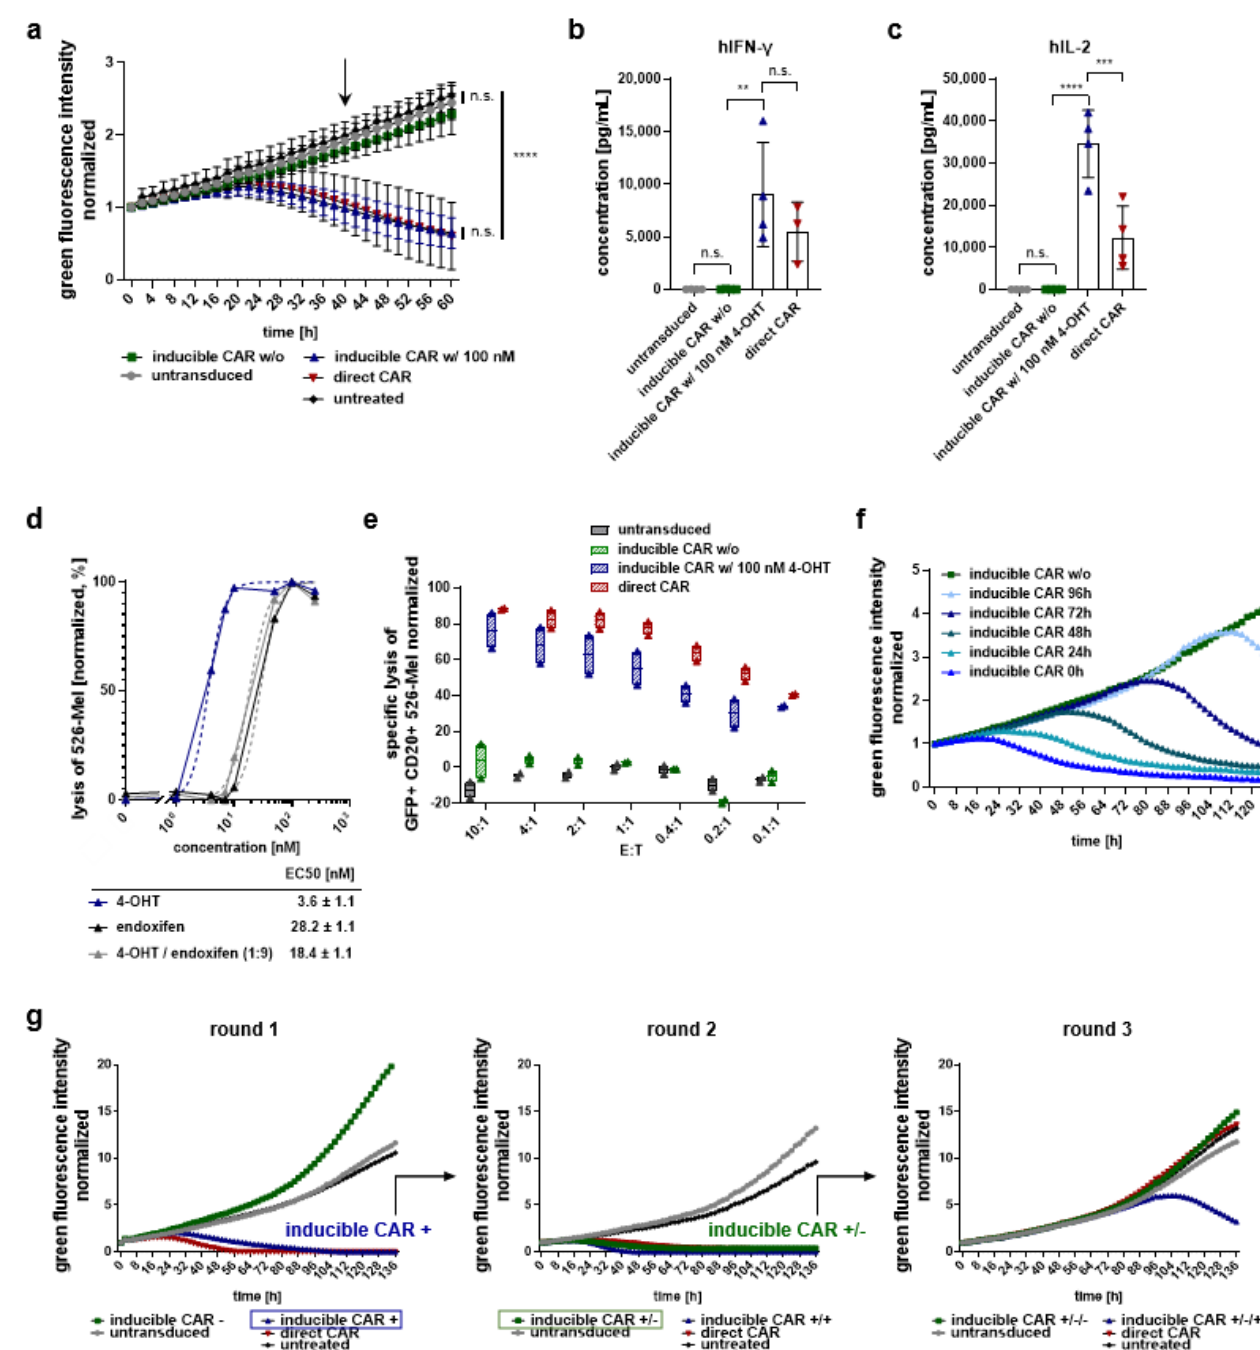
Figure 2. Inducible CAR T cells show efficient cytotoxic activity in the presence of 4-OHT, while CAR-related functions are lost after 4-OHT discontinuation in vitro. ( a ) T cells expressing ∆ LNGFR were co-cultured with GFP + CD20+ 526-Mel at an E–T ratio of 1:1 in the presence of 100 nM 4-OHT added at the start of the assay. T cell numbers were adjusted to LNGFR expression implicating equal transduced and total T cell numbers in each well. Growth of GFP + CD20 + 526-Mel was monitored in 2 h intervals over a period of 60 h using a live-cell imaging device (IncuCyte). The arrow indicates the time point of cytokine analysis. ( b , c ) The concentration of human IFN- γ ( b ) and IL-2 ( c ) was analyzed in the supernatant 40 h after assay initiation by MACSPlex Cytokine 12 Kit. ( d ) Inducible CAR T cells were co-cultured with GFP + CD20 + 526-Mel at an E–T ratio of 1:1 in the presence of varying concentrations of 4-OHT and/or endoxifen. Specific lysis of GFP + CD20 + 526-Mel was measured 40 h after co-culture setup, log transformed and normalized. Non-linear regression was performed to calculate EC 50 values. ( e ) Cytolytic activity of T cells against GFP + CD20 + 526-Mel at varying E–T ratios was assessed 40 h after co-culture set-up in the presence or absence of 100 nM 4-OHT. ( f ) The inducer drug 4-OHT was added at different time points at a concentration of 100 nM to the co-culture of inducible CAR T cells and GFP + CD20 + 526-Mel. ( g ) T cells were co-cultured with GFP + CD20 + 526-Mel at an E – T ratio of 1:1 in the presence of 100 nM 4-OHT added at the start of the assay. After each co-culture, T cells were harvested and 4-OHT was removed. T cells were then transferred onto new tumor cells in the absence (-) or presence (+) of 100 nM 4-OHT. Growth of GFP + CD20 + 526-Mel was monitored in 2 h intervals and expressed as normalized green fluorescence intensity. In ( f , g ) graphs represent pooled results of dif- ferent donors generated within one experiment. Graphs show data from n = 5 ( a ); n = 4 ( b , c ); n = 3 ( d ); n = 2 ( e – g ) different